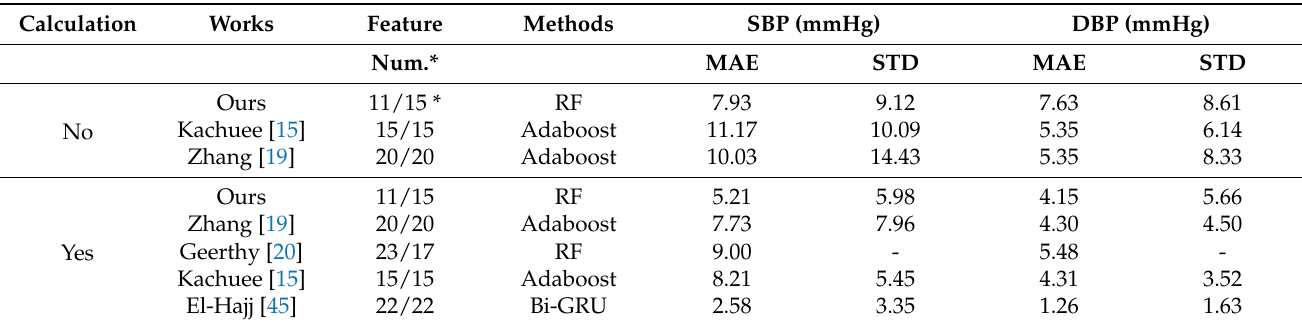
Table 5. Performance comparison with related